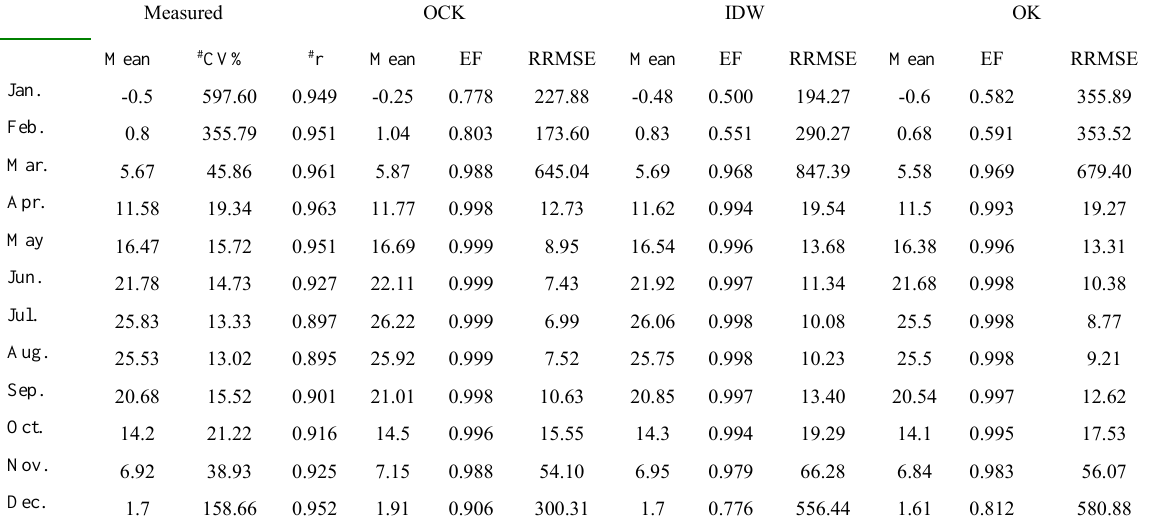
Table 2. Measured and predicted mean monthly air temperatures in the study